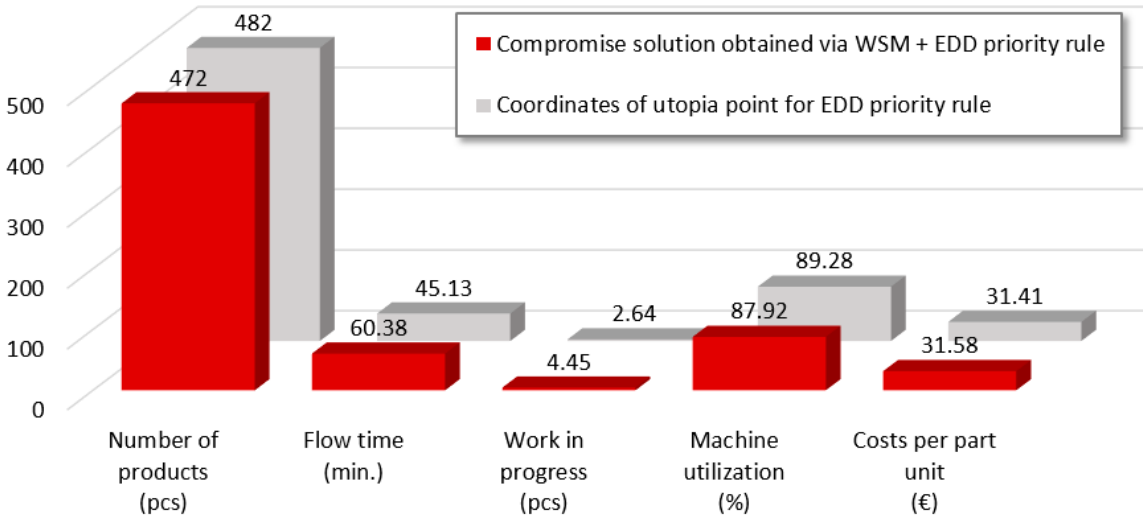
lected priority rule.